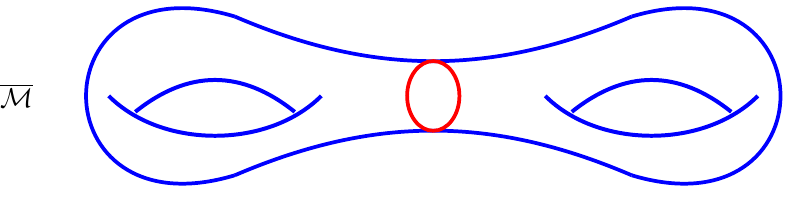
Figure 3 . The doubled compact manifold M without